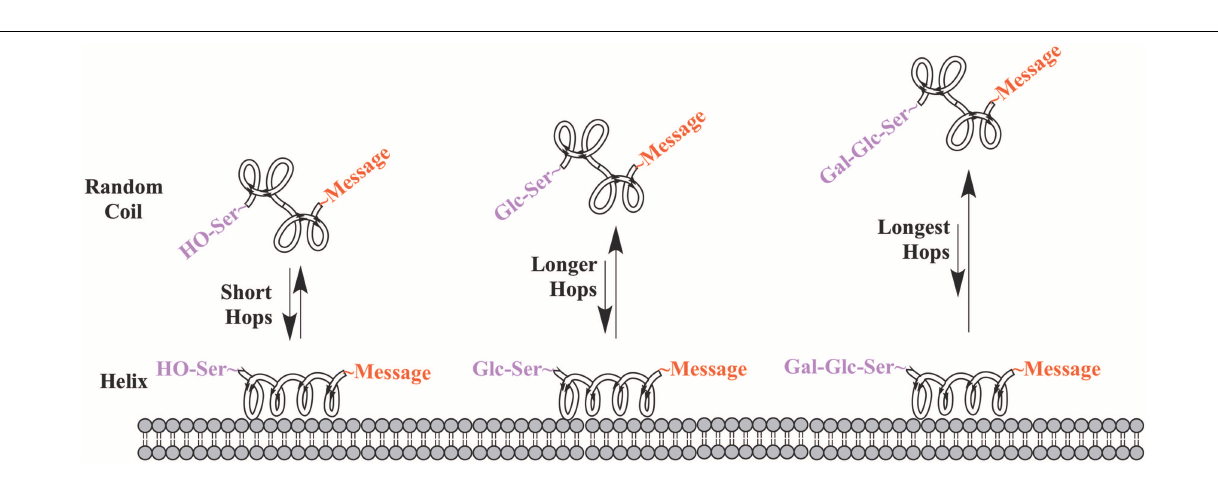
which is hydrophobic. Theoretically, a glycopeptide will have a higher affinity for the aqueous environment than its non-glycosylated analog, leading to reduced time spent on the membrane surface. This is hypothesized to lead to longer “hops,” presumably allowing a glycopeptide to interrogate more of a membrane surface and find